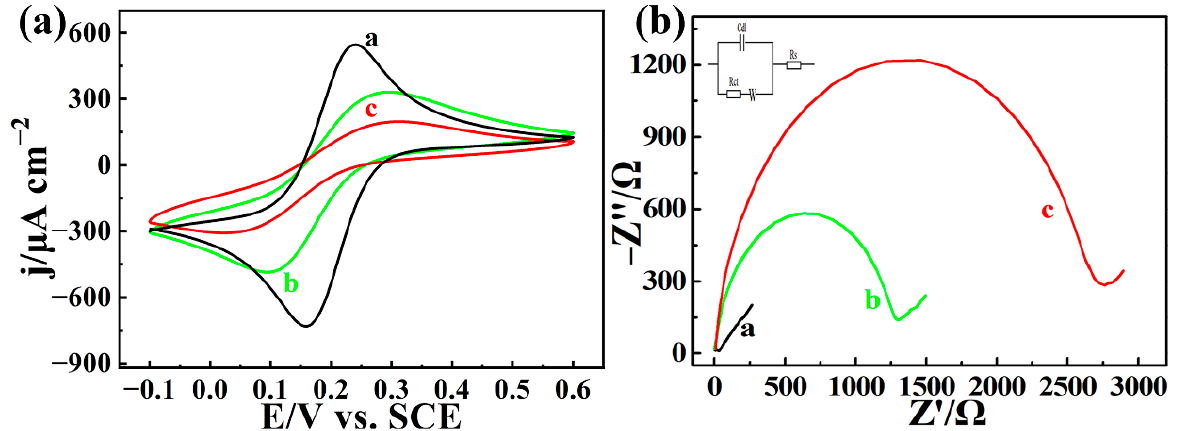
Figure 3. ( a ) CVs and ( b ) EIS of GCE (curve a), COF DHNDA-BTH /GCE (curve b), and AChE/COF DHNDA-BTH /GCE (curve c) in 0.1 M KCl with 5.0 mM [Fe(CN) 6 ] 3 − /4 − .